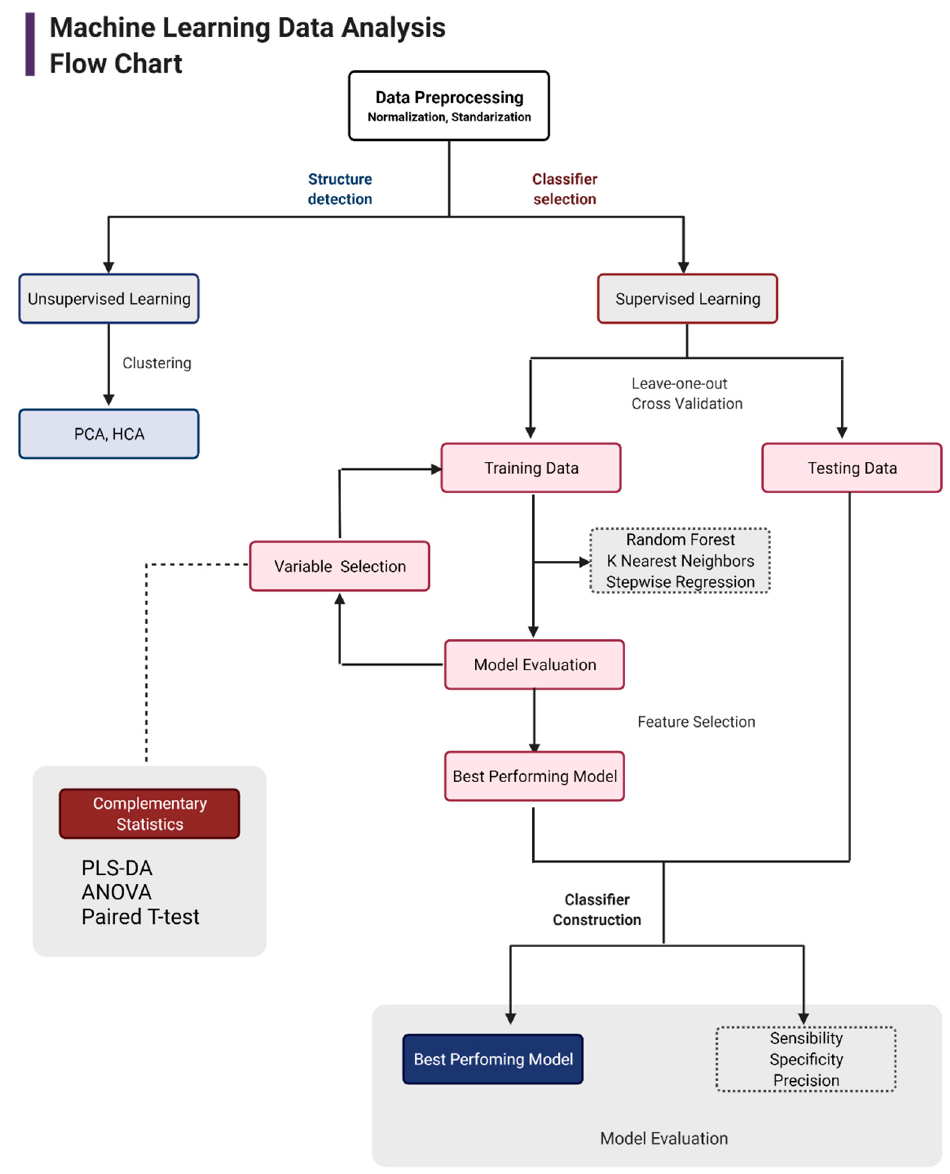
Figure 1. Flowchart for machine learning data analysis. This figure provides an overview of the approach used for model construction and data analysis. The left (structure detection) side indicates the unsupervised analysis, and the right (classifier selection) side indicates the supervised analysis and model construction process. Finally, the grey boxes at the bottom depict feature selection and final model evaluation parameters.